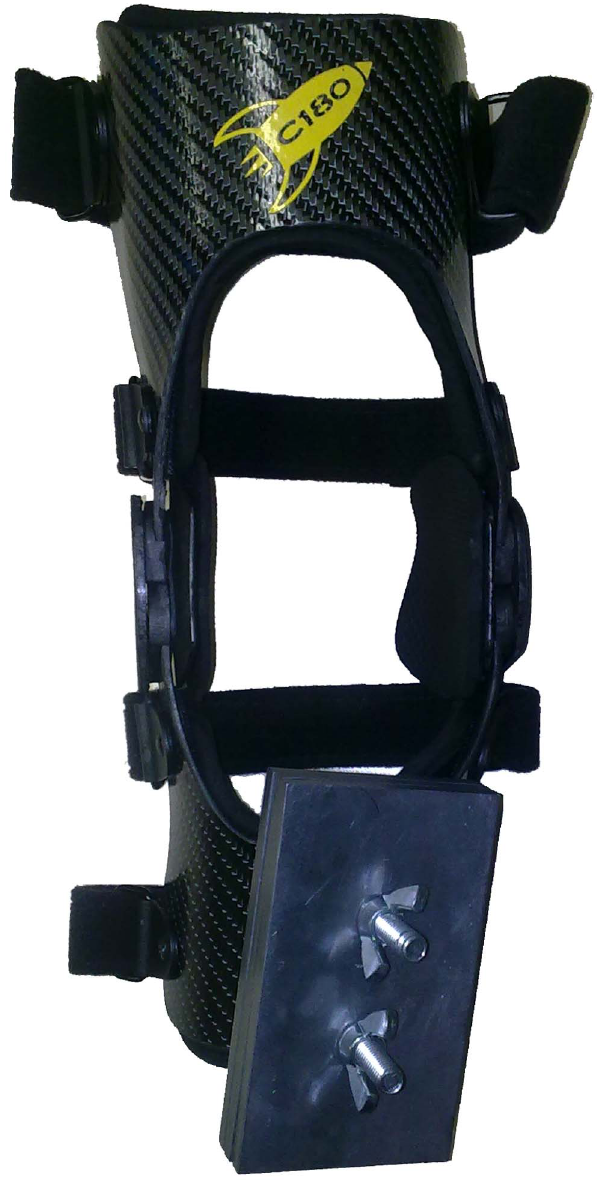
Figure 1. Knee brace. Knee brace and lead masses.